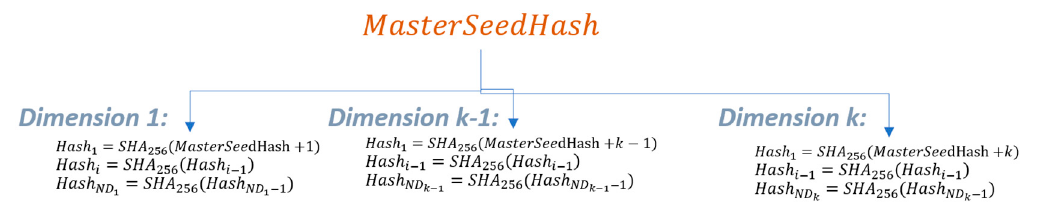
Figure 12. Multi-Dimensional Token Pools.